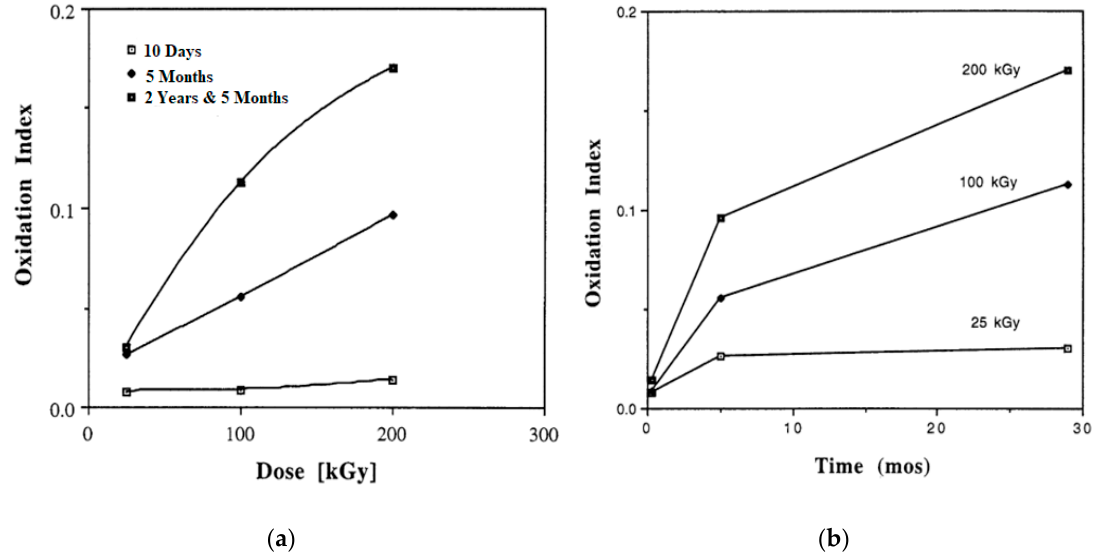
Figure 2. The change in oxidation index with ( a ) radiation dose; and ( b ) aging time. Reprinted with permission from [60]